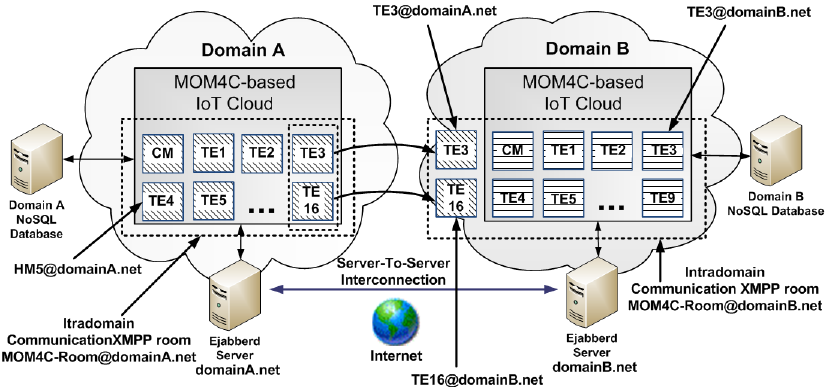
Figure 5. Example of federation between two MOM4C-based IoT